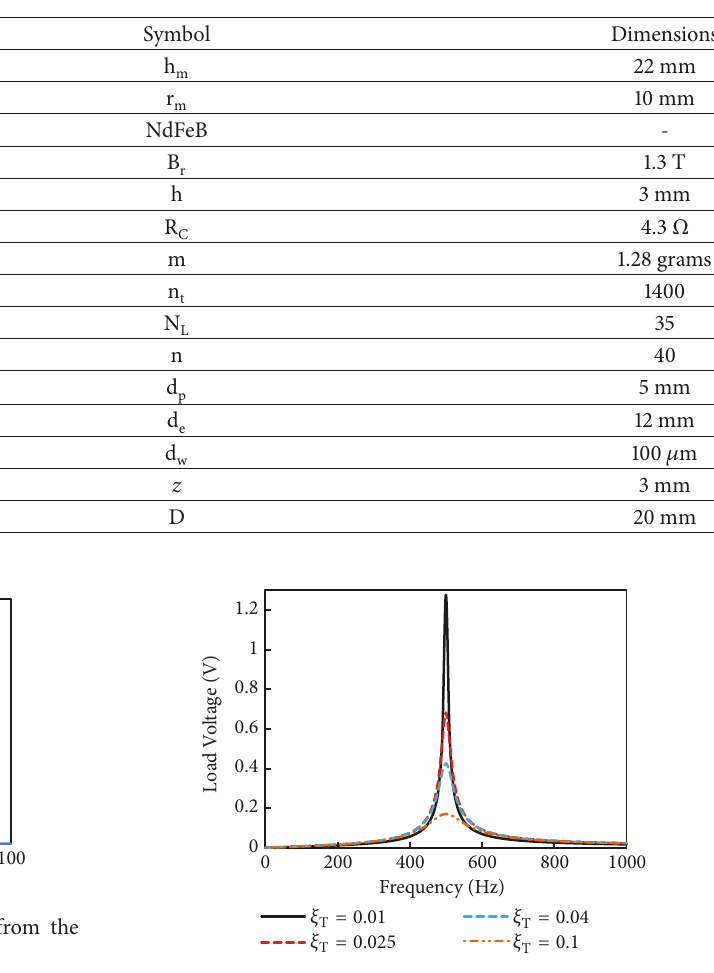
Figure 9: Frequency response of simulated load voltage of the